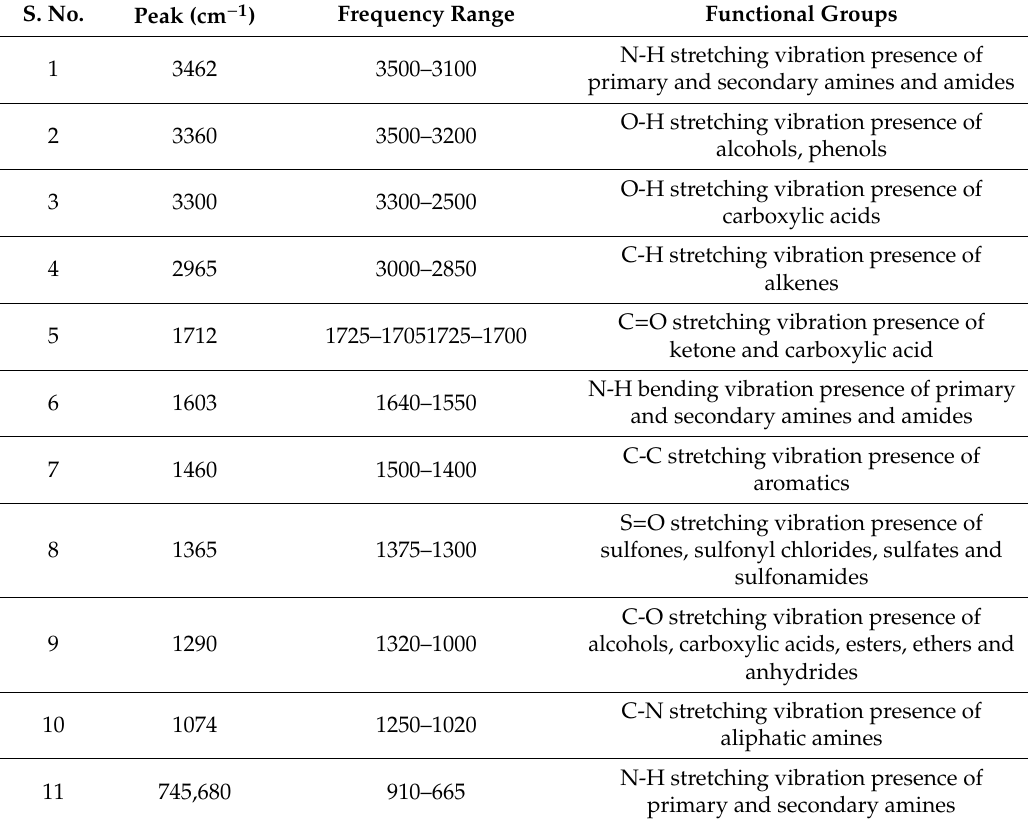
Table 2. FTIR spectra of M. esculenta leaves methanolic extract.